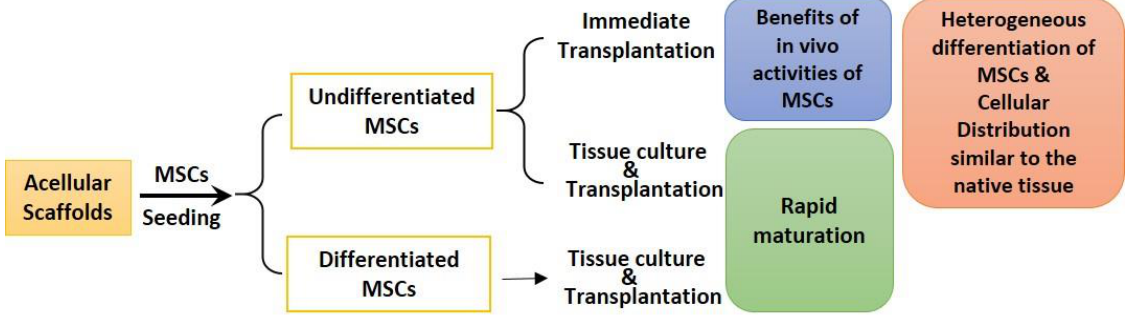
Figure 2. Potential outcomes of different recellularization strategies using MSCs.